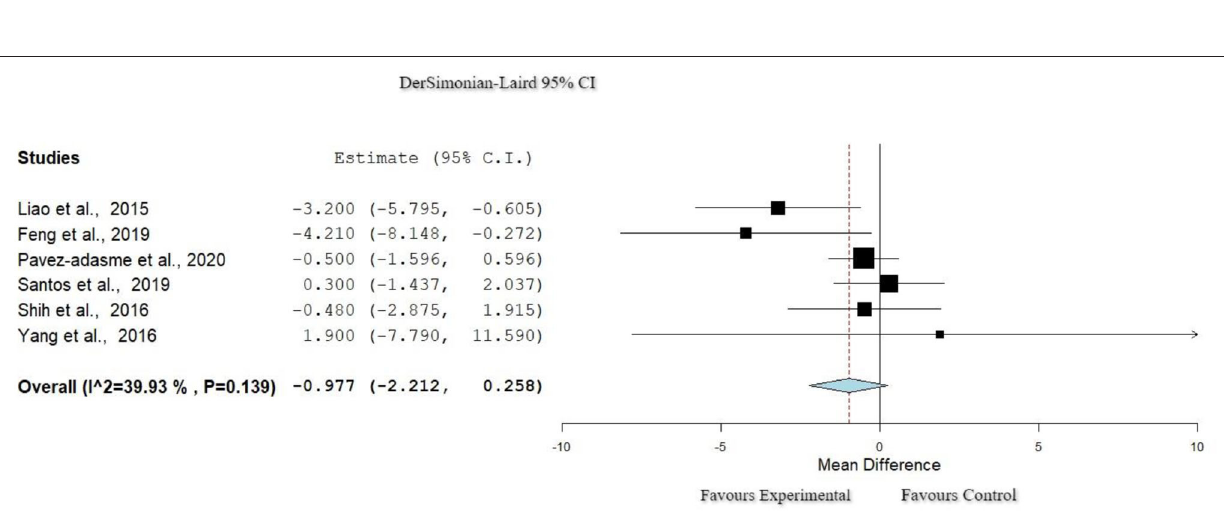
FIGURE 6 | Forest plot for Function: TUG. The red dash line represents the weighted mean difference of the included studies. The blue figure represents the weighted 95% CI of the included studies. TUG, Timed Up and